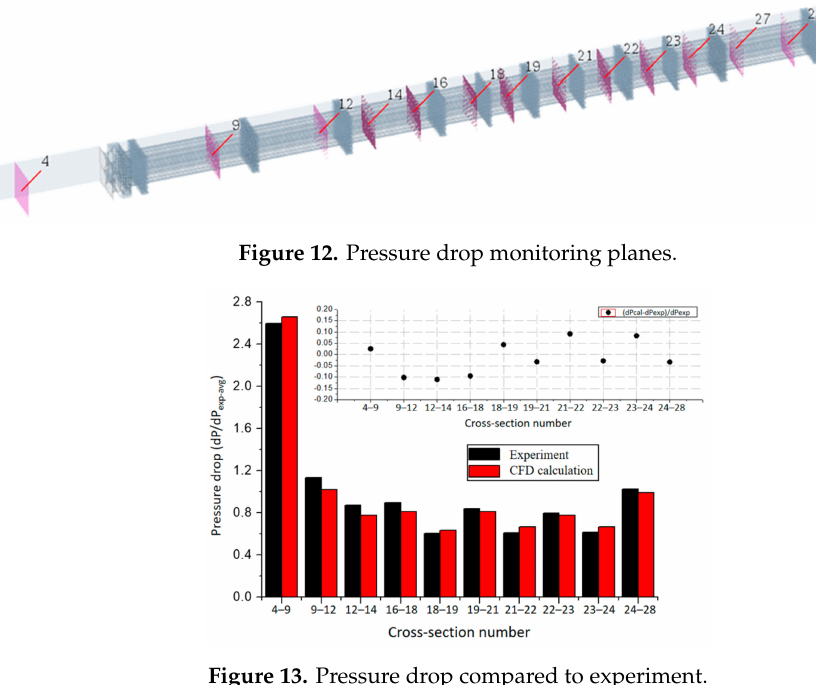
Figure 13. Pressure drop compared to